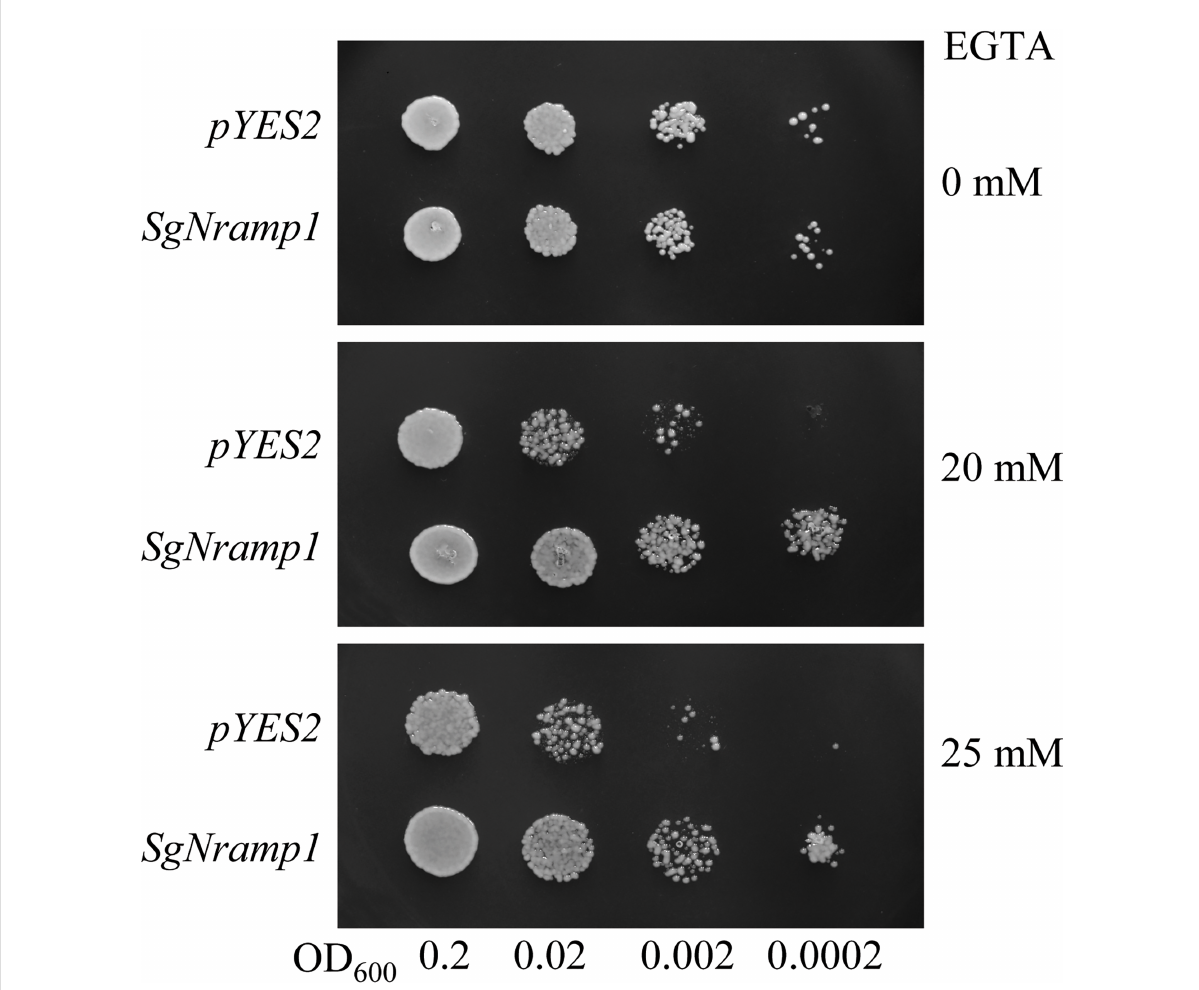
FIGURE 7 Manganese transport analysis of SgNramp1 in yeast. The yeast mutant D smf1 expressing either the pYES2 empty vector or SgNramp1 was spotted on SC-U/Gal solid medium containing 0, 20, or 25 mM Mn-chelator EGTA. The photo shows the growth of yeast cells at 30°C for 2